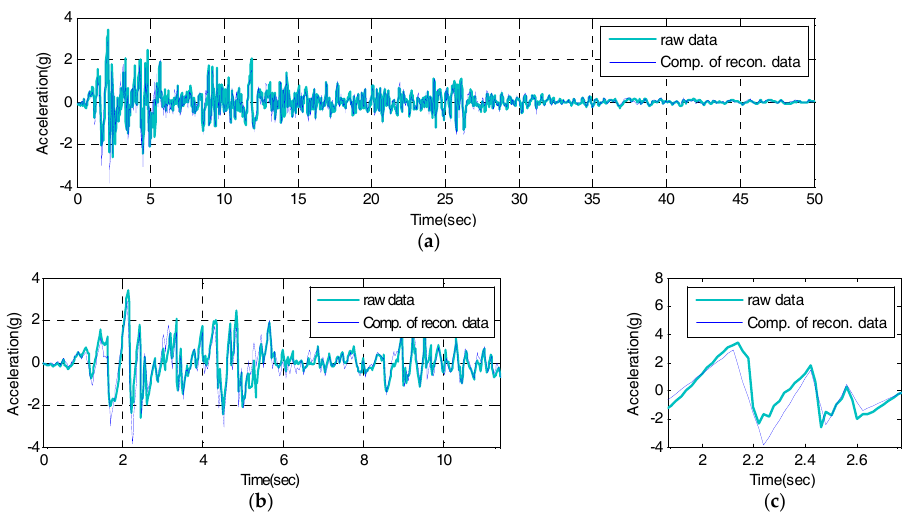
Figure 19. Time domain of raw signal vs. compressive signal : ( a ) Time from 0 to 50 s; ( b ) Detail 1; ( c ) Detail 2.